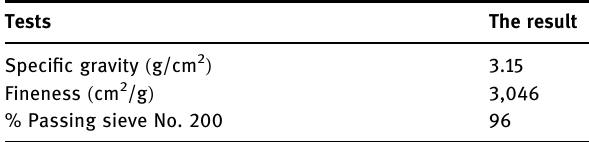
Table 4: Physical properties of fi